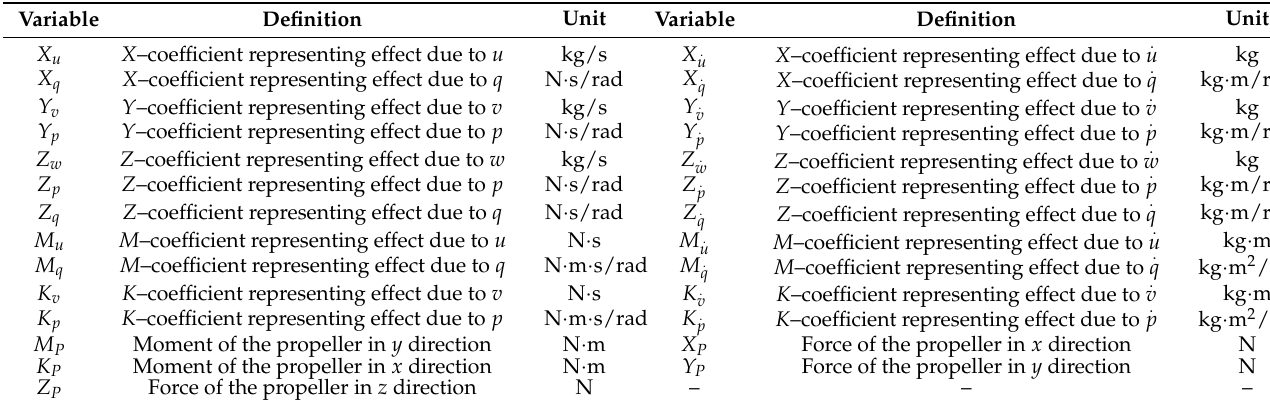
Figure 5. The definitions of coordinate frames. Table 2. The nomenclature of the hydrodynamics